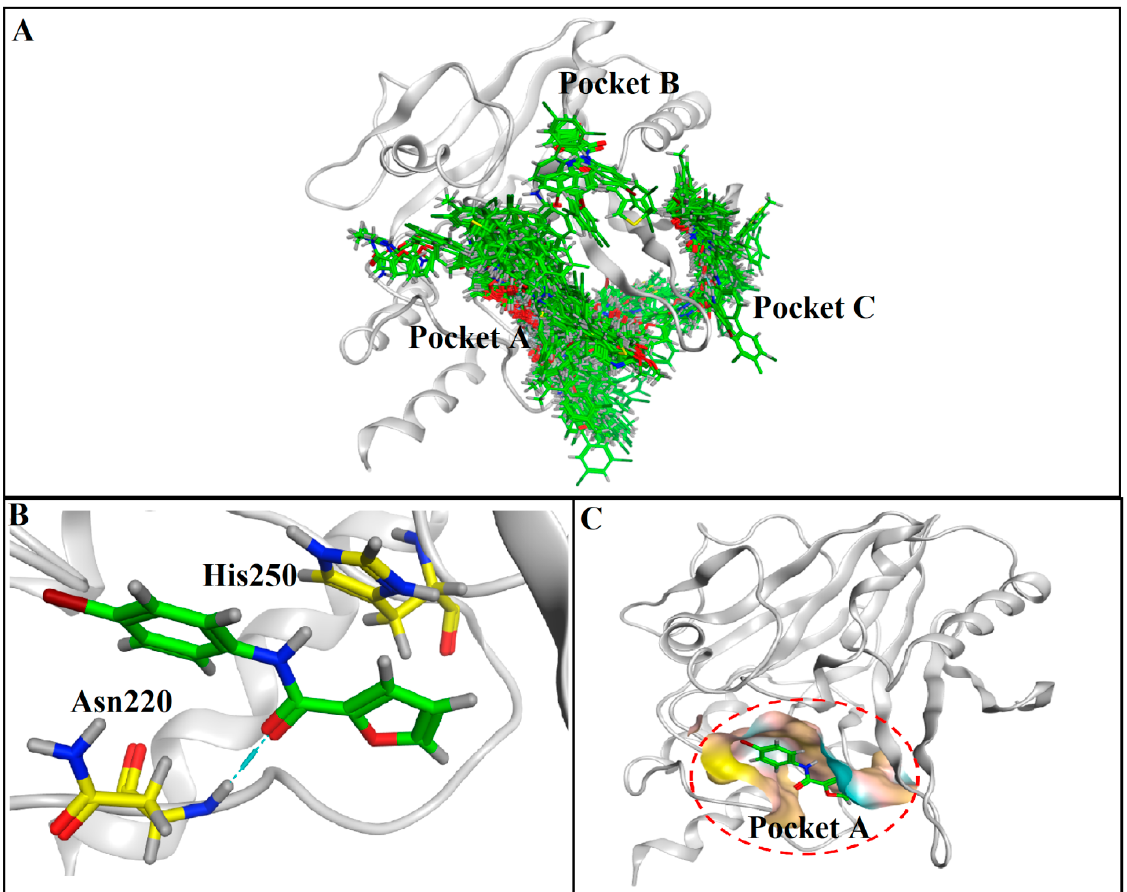
Figure 3. Conformational analysis and interaction pattern of NDM-1-embelin protein with highly active compound 3 . ( A ) Three major binding pockets (pocket A, pocket B and Pocket C) were identified and the majority of the ligand conformations found in the pocket A of NDM-1 protein, which enhances the confidence that pocket A is the most probable binding cavity. ( B ) Molecular interactions (hydrogen bonding and hydrophobic) of highly active compound 3 with NDM-1 protein. ( C ) The least energy conformation of compound 3 residing in pocket A, depicting the significant role of Pocket A in ligand binding.